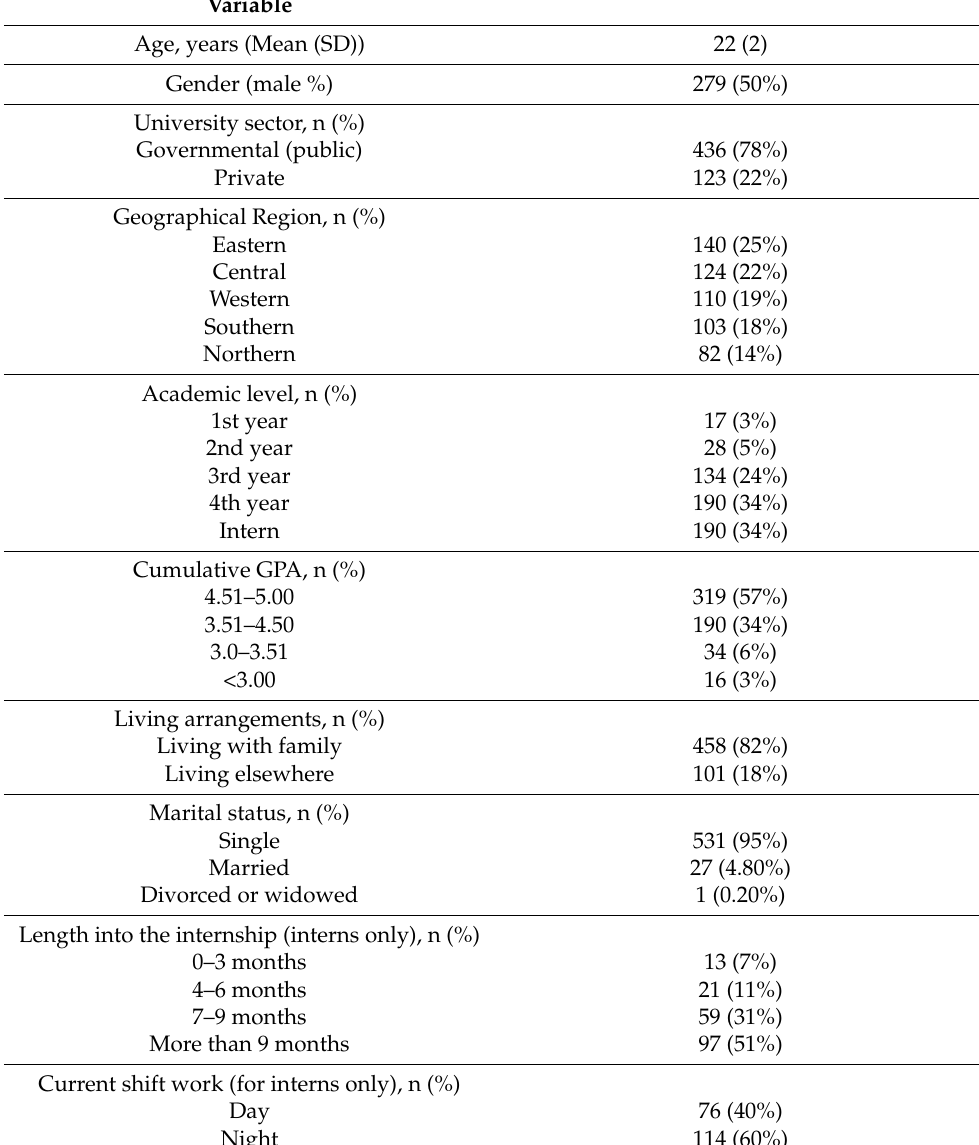
Table 1. Demographic data of study participants (n =